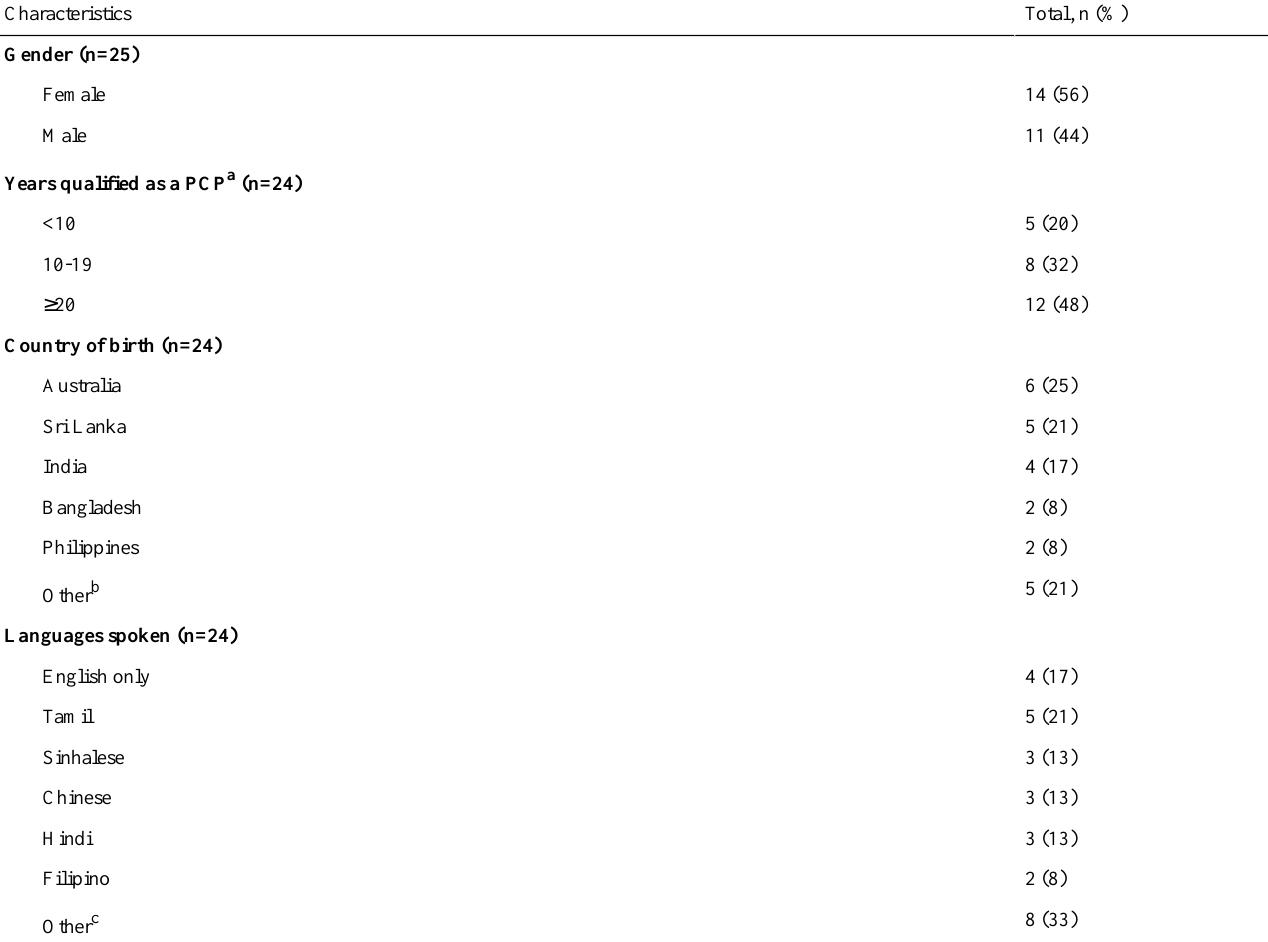
Table 1. Participant descriptive